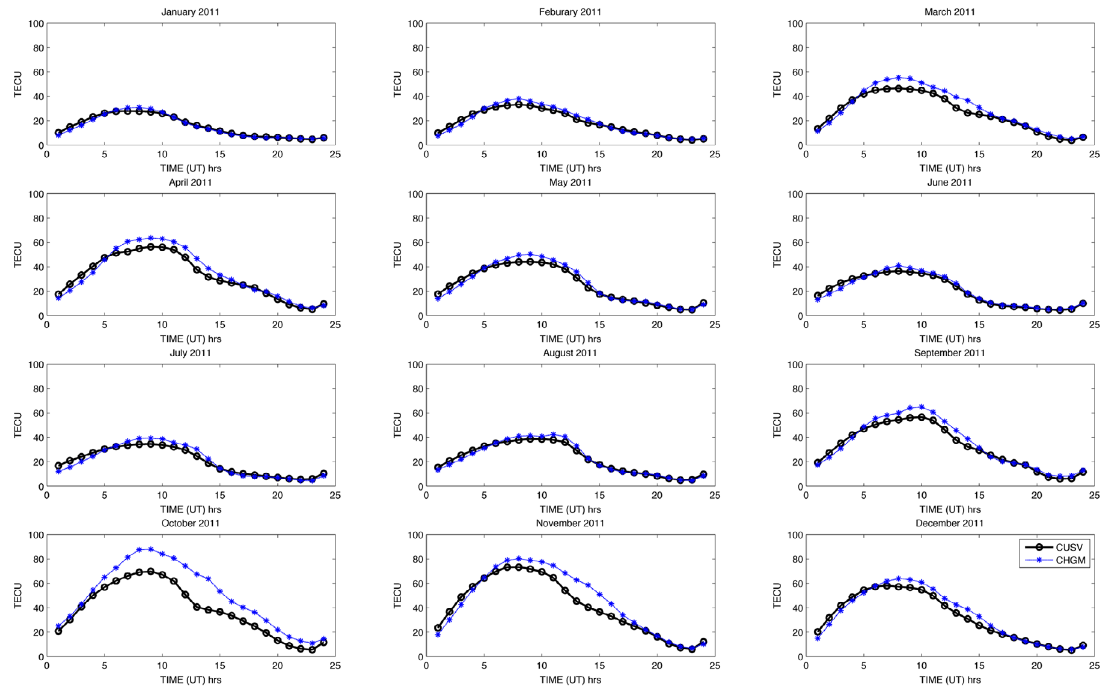
Figure 10. Comparison of monthly variations of mean GPS TEC values at CHGM and CUSV stations during the period 2011.